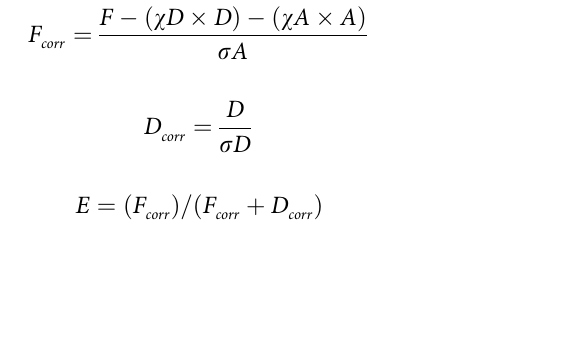
S1 Fig. Crystal structure of C-terminally truncated Sso7c4. (A) The crystal of C-terminally truncated Sso7c4 contains three homodimers in the asymmetric unit with the space group P 3 (B) In the trigonal crystal of C-terminally truncated Sso7c4, the α carbons of the three mole- cules in one asymmetric unit superimpose well. The r.m.s.d. values are 0.27 Å for 86 atoms and 0.34 Å for 79 atoms, represented by chain AB vs. chain CD and chain AB vs. chain EF, respectively. (C) The superposition of the α carbons of the wild-type and C-terminally trun- cated crystal structures and the NMR solution structure (2L66) is shown. By comparing the r. m.s.d. value of chain AB between the wild-type and C-terminally truncated structures, which is 0.35 Å for 85 atoms, the r.m.s.d. values between the coordinates of the wild-type and C-ter- minally truncated crystals and the coordinates of the NMR solution model are 1.56 Å for 92 atoms and 1.64 Å for 90 atoms, respectively. The crystal structures of the wild-type and C-ter- minally truncated proteins are similar to each other, but they have larger deviations from the NMR solution structure. The wild-type structure is shown in magenta, the C-terminally trun- cated structure is shown in blue, and the 2L66 structure is shown in green. S2 Fig. Intermolecular interactions of the Sso7c4 monomers at the dimerization interface. K45 in β 4 and K45 0 in β 4 0 , together with D38 (D38 0 ), S40 (S40 0 ) and E41 (E41 0 ), form a net- work of electrostatic interactions and water-mediated hydrogen bonds between the two mono- mers. The water molecules are drawn as cyan spheres. The hydrogen bonds are shown as yellow dashed lines. S3 Fig. Sulfate bound to the top surface of Sso7c4. The ionic interactions surrounding sulfate X203 are provided by the NH groups of N12 0 and Q14 0 in one monomer and Q14 in the other monomer. The hydroxyl group of S10 0 forms a hydrogen bond with sulfate X203, which